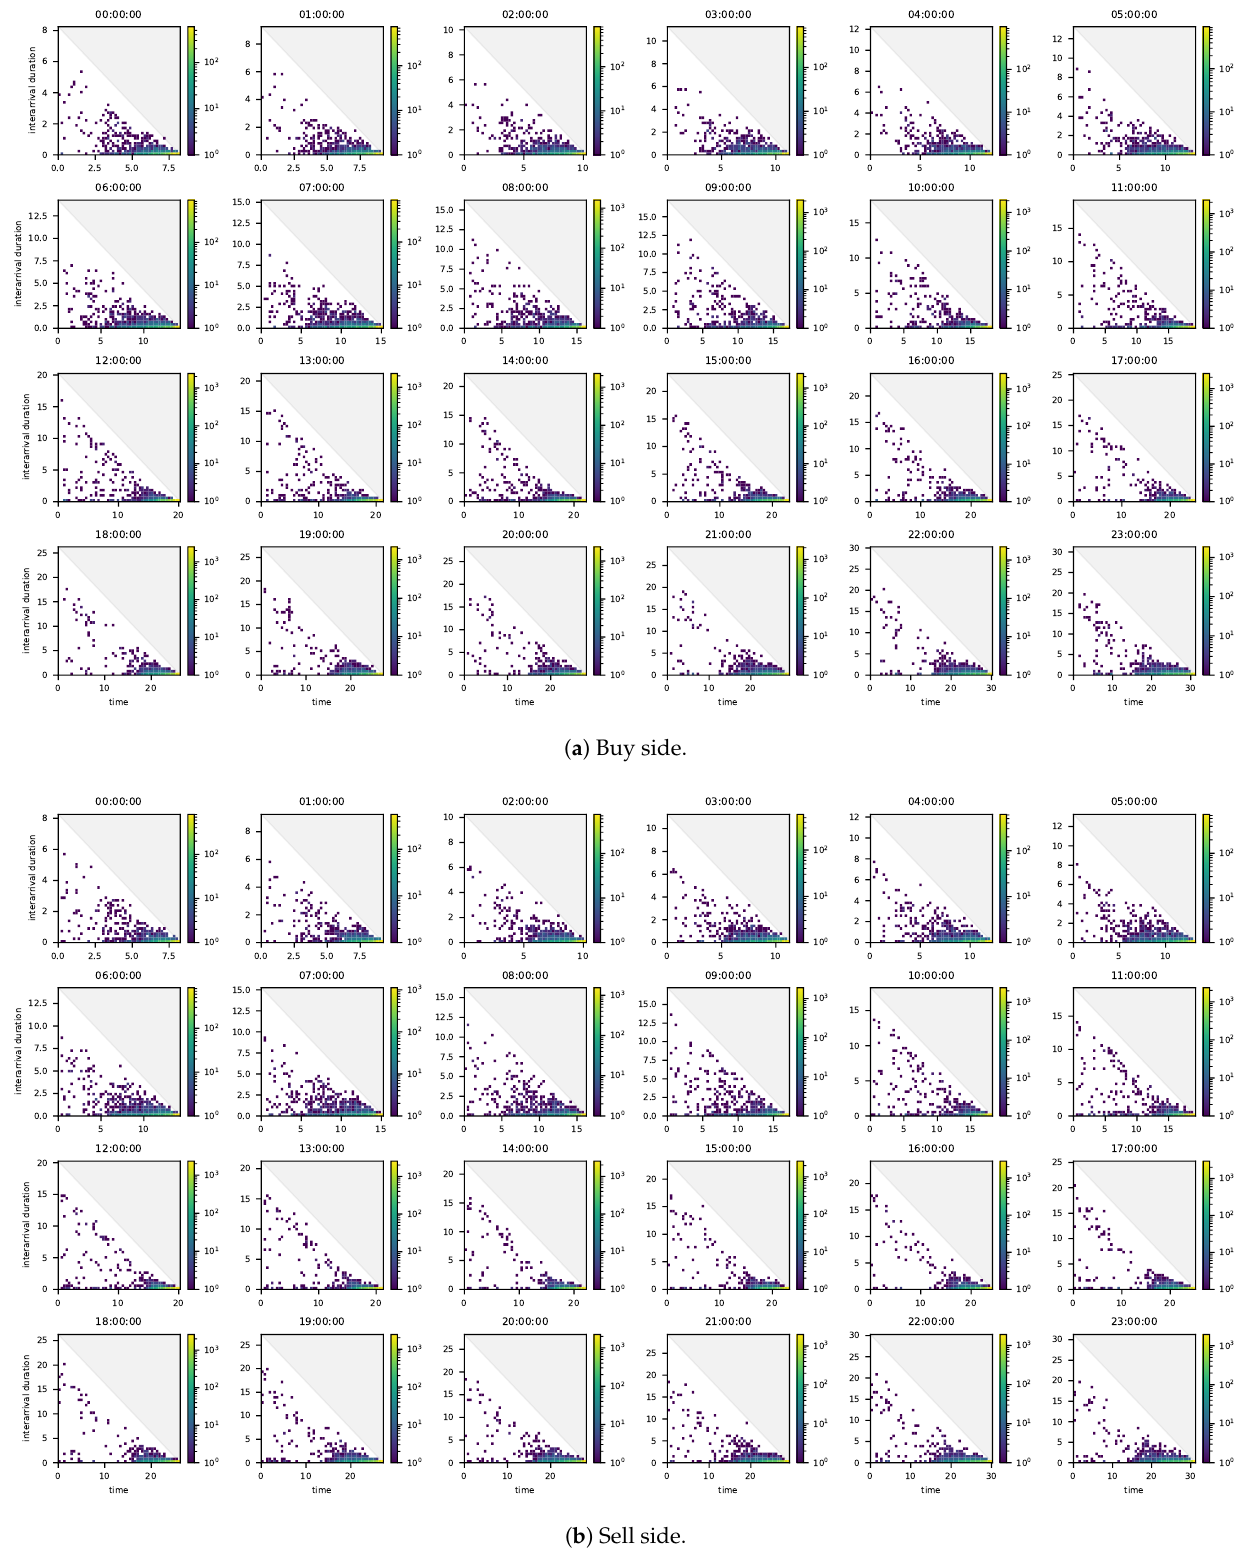
Figure 1. Two-dimensional histograms of times at which buy (left) and sell (right) market orders were placed (horizontal axis) and durations between the time at which a market order was placed on one side and the time of the next market order on that side (vertical axis). Data: All contracts with hourly delivery in Q2/2015. For each contract the time at which trading ends is set to the time at which trading ends for the hourly contract with delivery start at 21:00:00